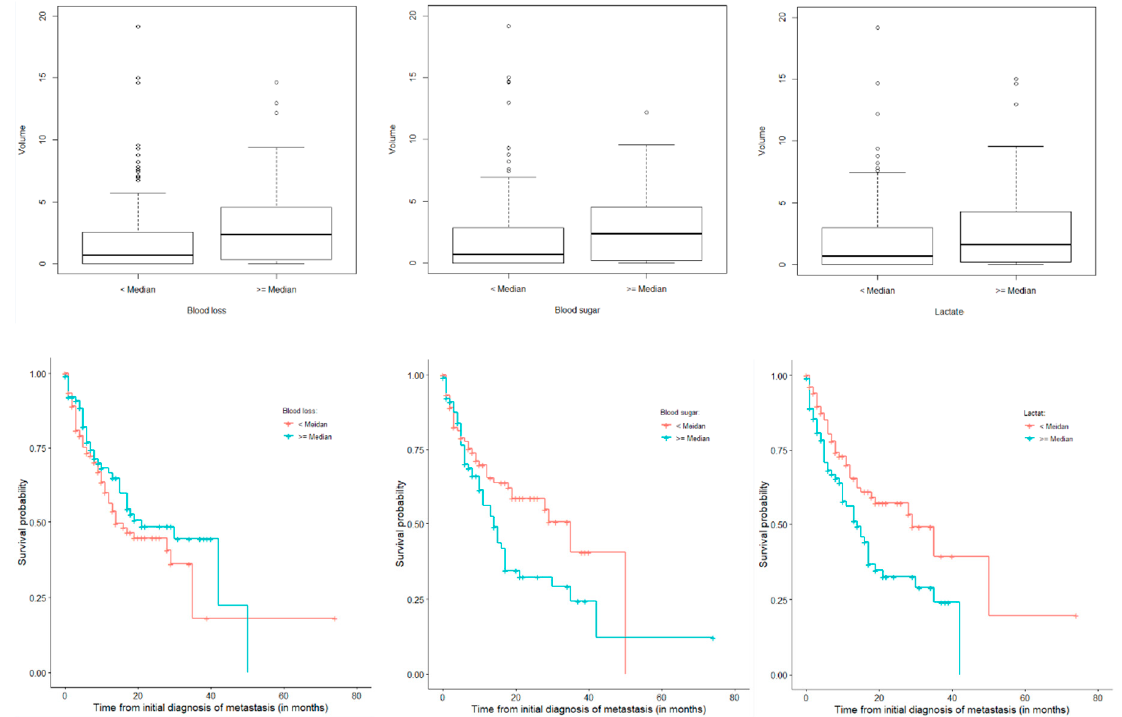
Figure 3. Box plots (dichotomized by the respective median) and Kaplan–Meier estimates of blood loss, blood glucose and lactate levels. Infarct volume.